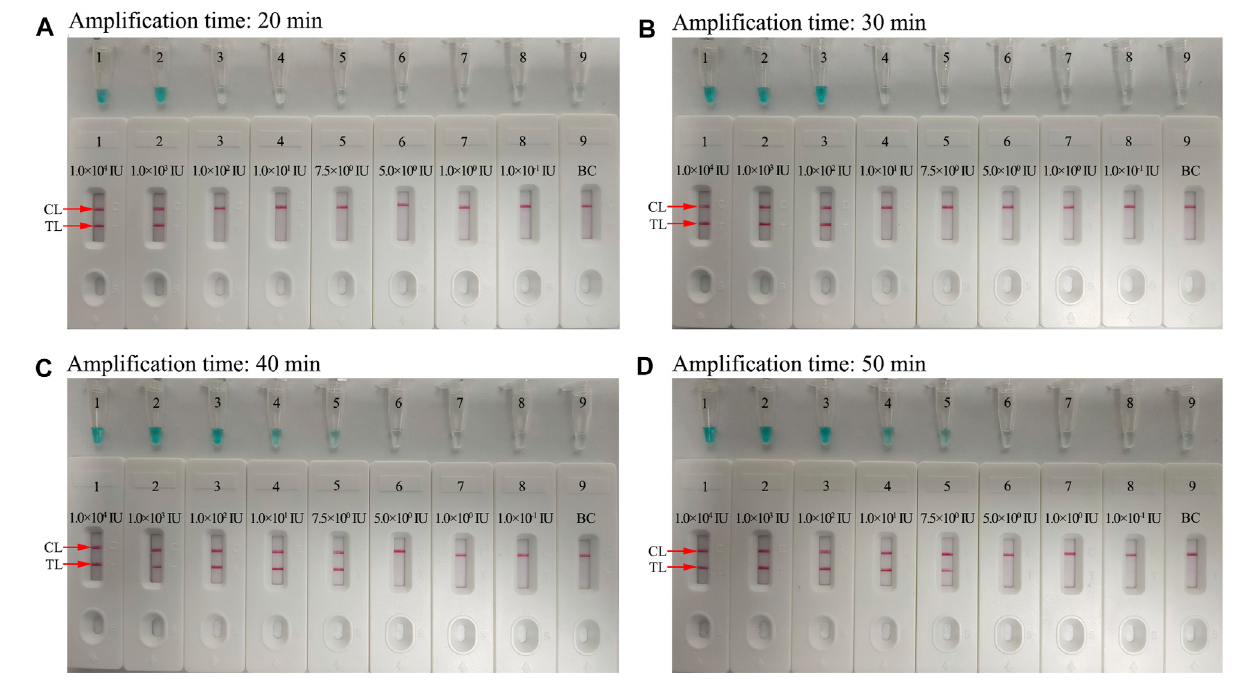
Frontiers in Bioengineering and Biotechnology |